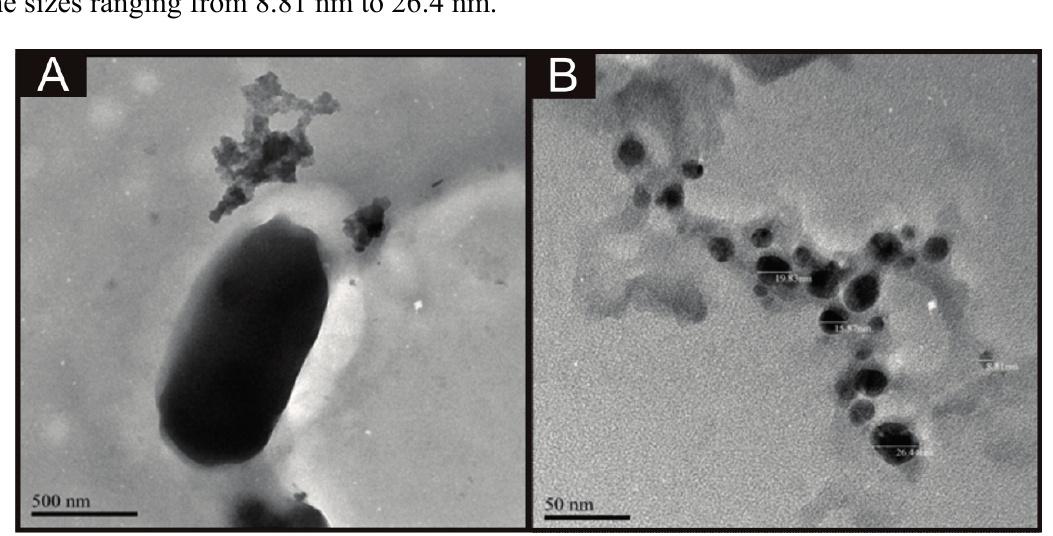
Figure 1. TEM images of the CoTAPC prior to the reaction with (CTACl; C1 6 H 33 N(CH 3 ) 3 Cl)-CTAB ( A ) and the nano-CoTAPC ( B ) as a result of this reaction with the sizes ranging from 8.81 nm to 26.4